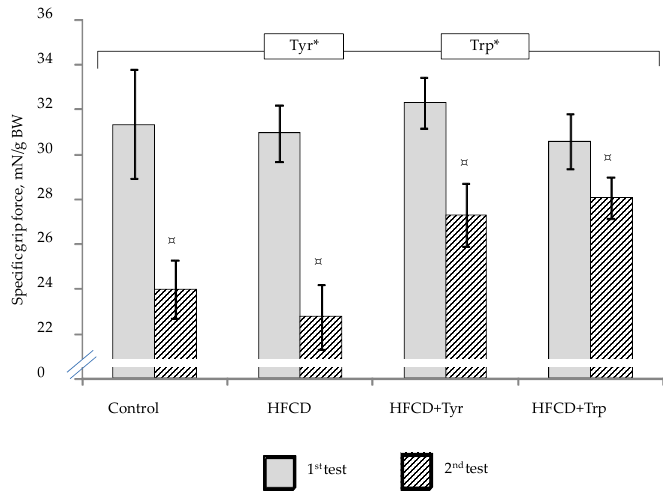
Figure 3. Muscle compression force (specific grip force of the forepaws) in rats during the first and second testing, mean ± standard error of the mean. The bracket above the bars denotes significant dependence on the factors: “Tyr” and “Trp”, p < 0.05, 3-way ANOVA. * only in the second test; ¤ the difference between the first and second tests is significant, p < 0.05, Wilcoxon’s criteria for pairwise comparisons. The number of animals in the groups was 8.